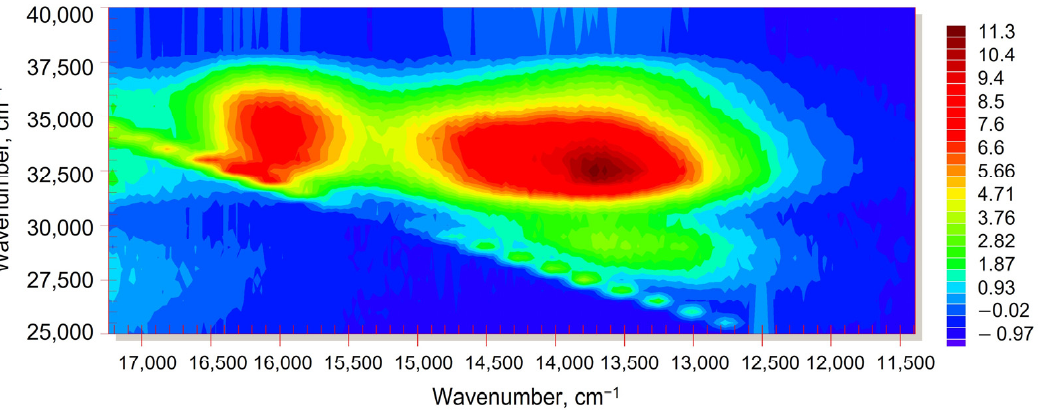
Figure 5. Excitation–emission fluorescence map (wavenumbers scale) for fullerene C 60 , 50.0 µ M in n -hexane, Region B. Excitation/emission slits, 2.5/2.5 nm; detector voltage, 700 V. Scanning pitch, 15 nm. Y -axis is excitation, X -axis is emission.